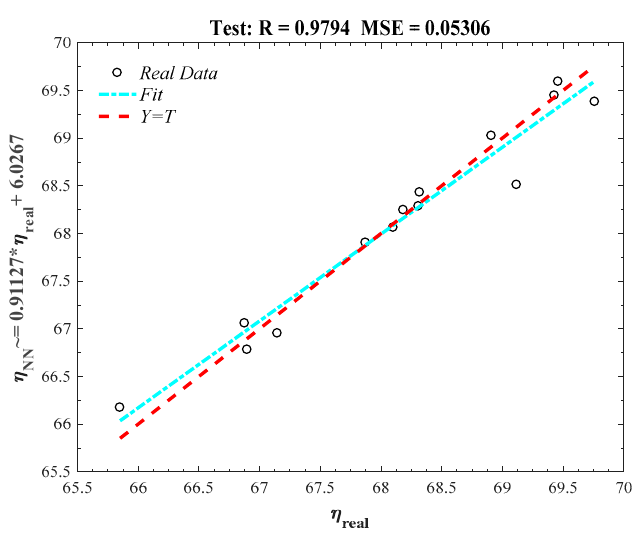
Figure 10. The regression line diagram for validation data.